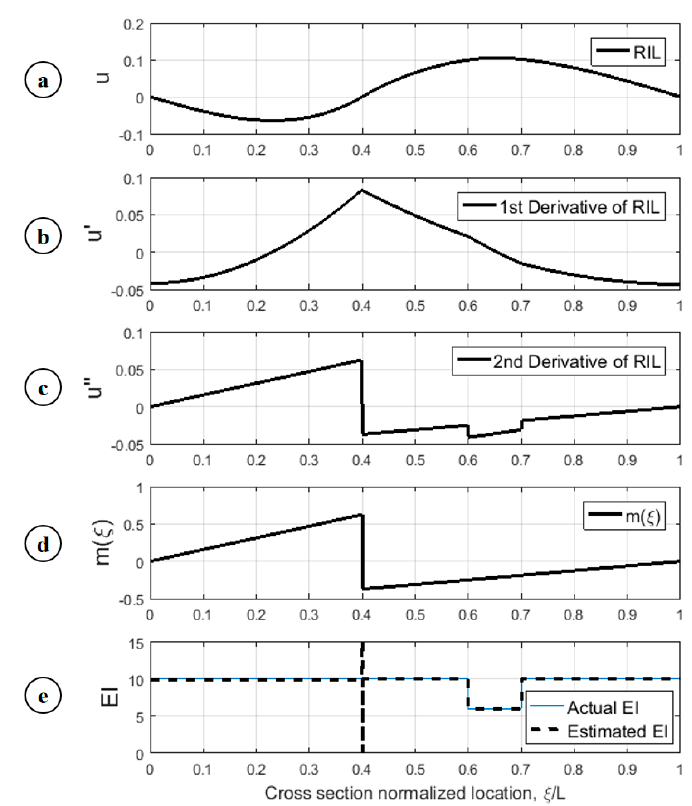
Figure 7. Example-2 Analysis results; ( a ) recorded RIL; ( b ) first derivative of RIL; ( c ) second derivative of RIL; ( d ) diagram of moment m ( ξ ) ; and, ( e ) beam flexural rigidity estimation